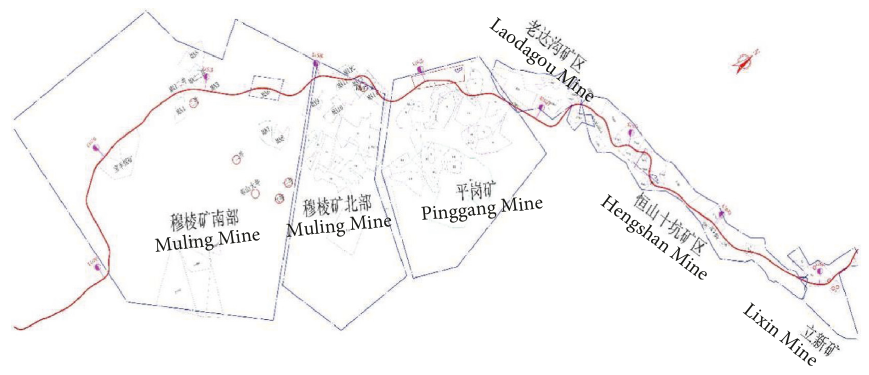
Figure 4: Schematic diagram of the reconstruction and expansion project route of the Jixi section of the national highway Dan-A